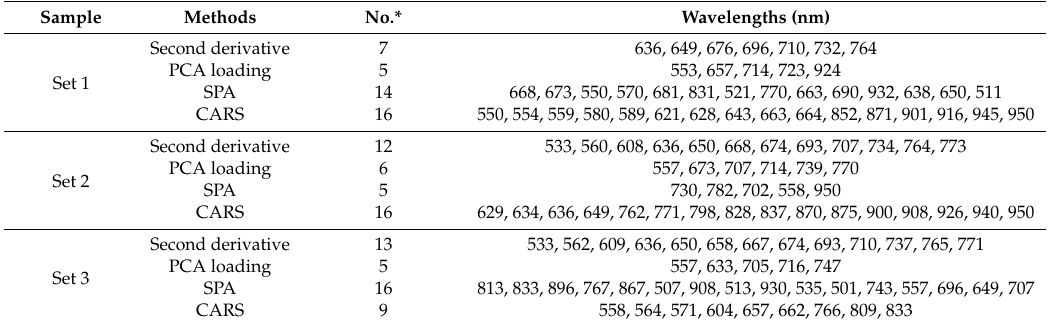
Table 2. The optimal wavelengths selected by the PCA loadings, second derivative spectra, successive projections algorithm (SPA), and competitive adaptive reweighted sampling (CARS) for the three sample